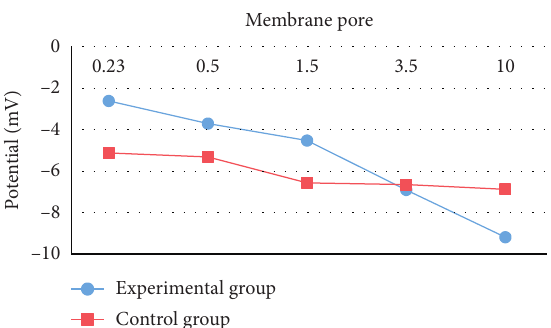
Figure 3: Changes in urine microcrystal ξ potential in the two groups.